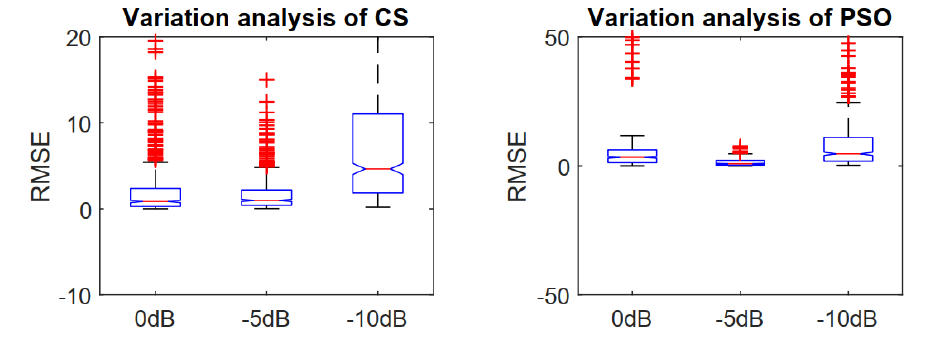
Figure 10. Variation analysis of CS and PSO by estimating six sources.